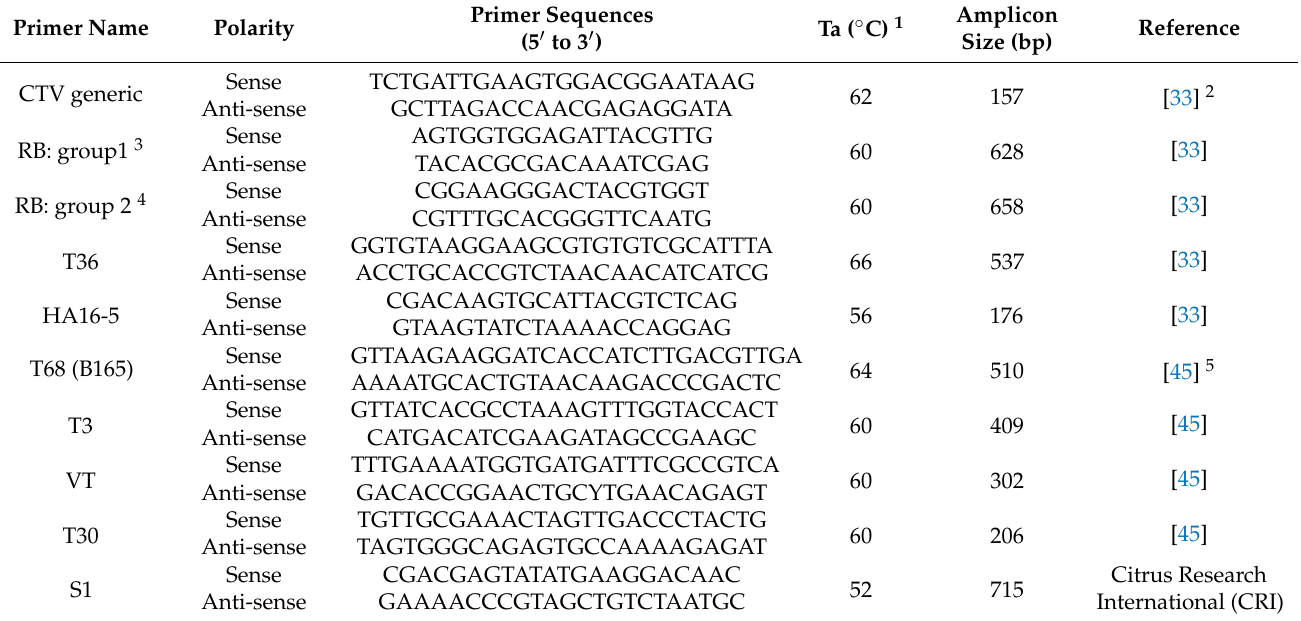
Table 1. Citrus tristeza virus (CTV) species and genotype-specific primer sequences used in a two-step